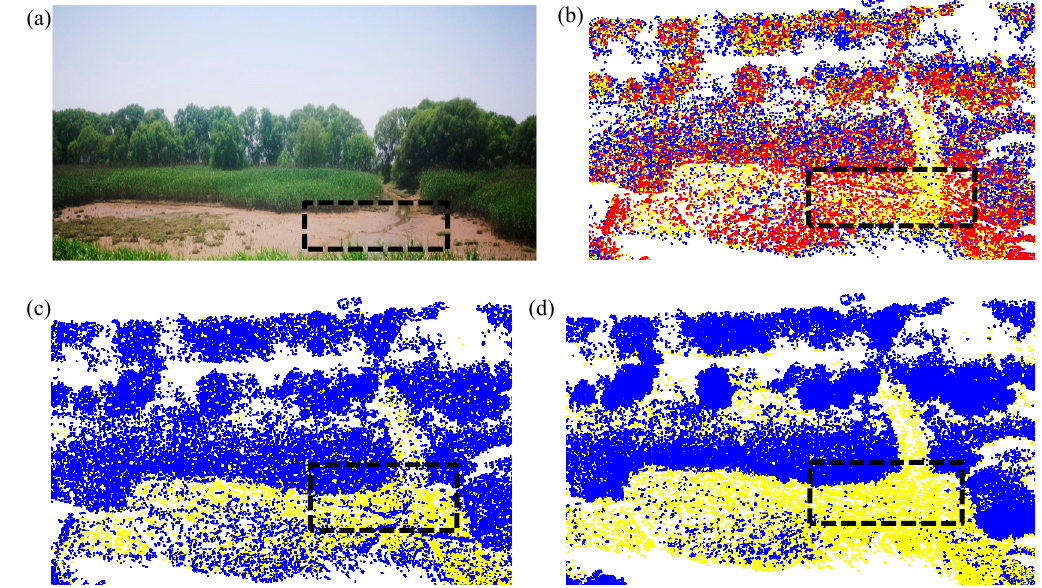
Figure 12. Comparison of ( a ) an RGB photograph on site and the corresponding region in the classification results by ( b ) original intensity data, ( c ) corrected intensity data by the improved method, and ( d ) manual and software (LiDAR360) combination. The yellow, blue, and red points represent muddy flat, vegetation and cement road, respectively. Ditches are in the black dotted rectangles.